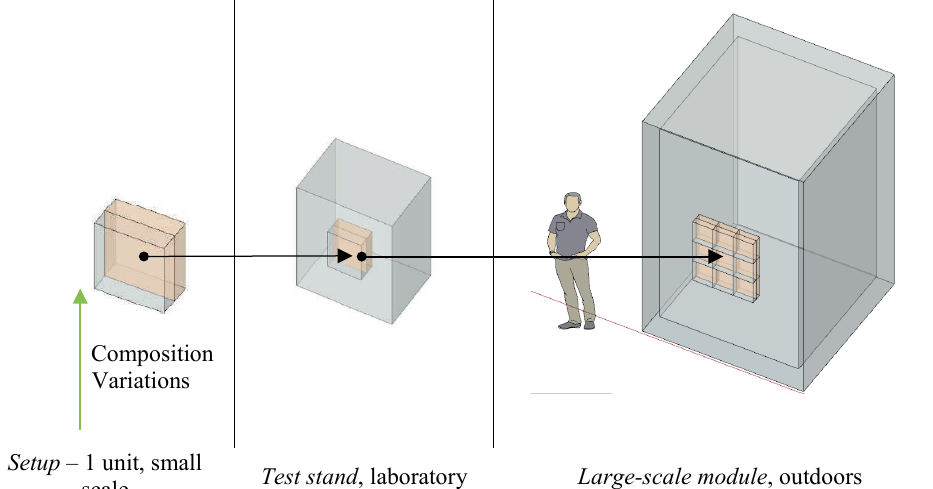
Fig. 2. The terminology used in